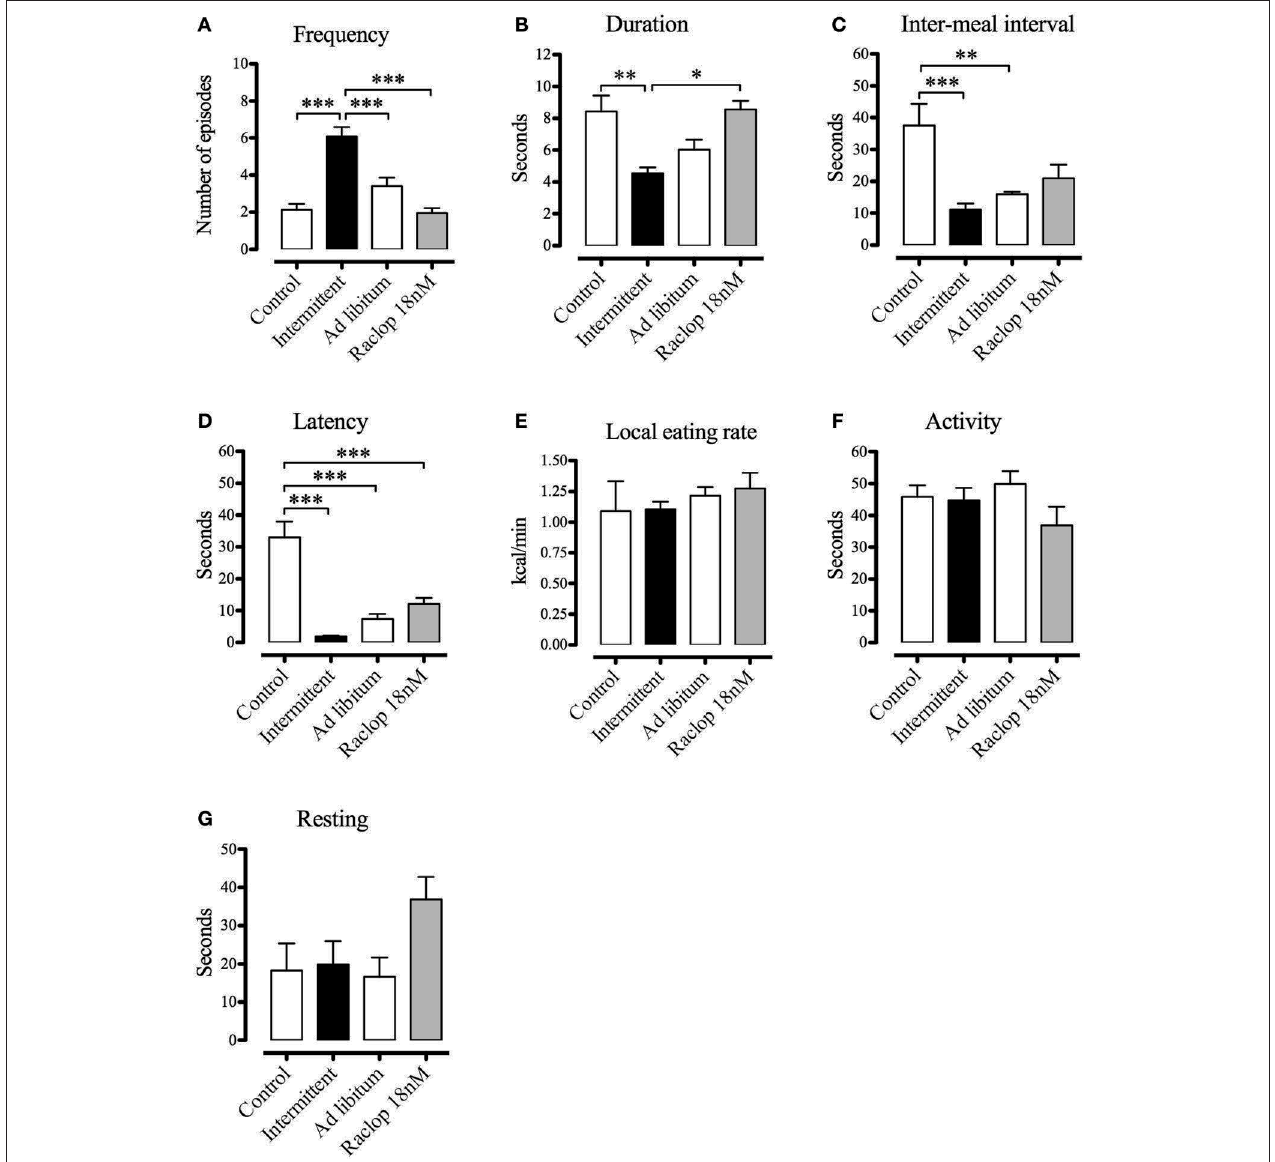
FIGURE 8 | Microstructure of feeding behavior parameters, including meal frequency (A) , meal duration (B) , inter-meal interval (C) , latency (D) , local eating rate (E) and durations of activity (F), and resting (G) of animals differentially exposed to the sucrose solution. A separate group of rats ( n = 4) had intermittent access to the sucrose solution during 28 days and after recovery from stereotaxic surgery, raclopride (18nM) was injected in the NAcS. Data expressed as means ± S.E.M. * p < 0.05, ** p < 0.01, *** p <